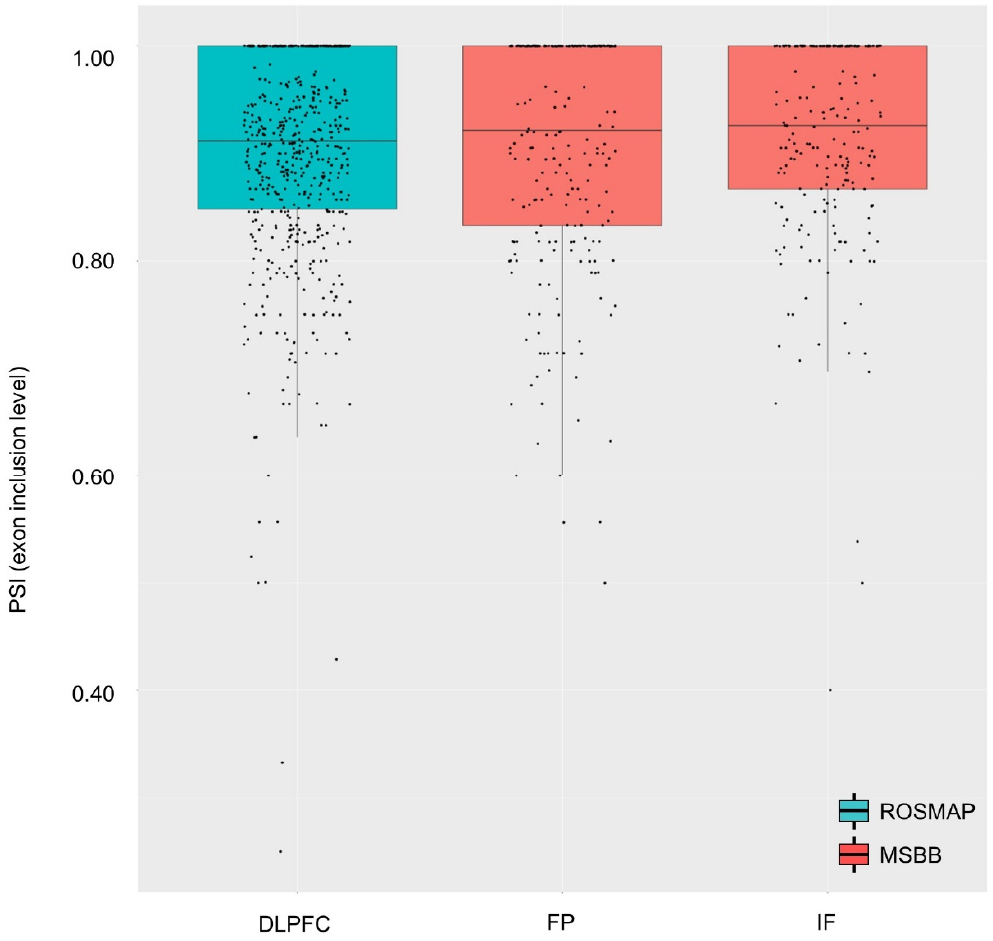
Figure 2. Distribution of TREM2 2nd exon PSI values for each investigated brain region. X -axis and Y -axis indicate PSI and brain regions, respectively. Cyan and red boxplots were respectively generated from ROSMAP and MSBB cohort datasets.